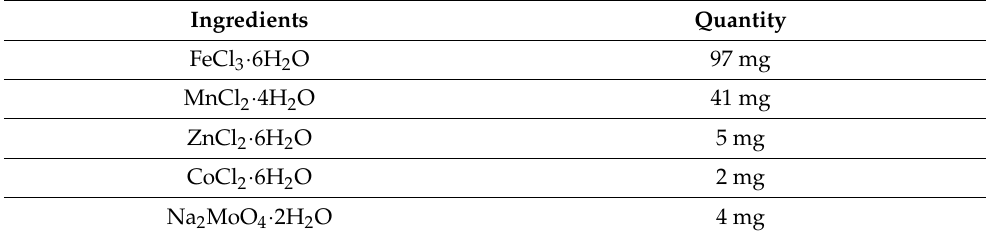
Table A2. Preparation of the microelement solution : Add to 1000 mL of distilled water 0.75 g Na 2 -EDTA and the minerals exactly in the following sequence.